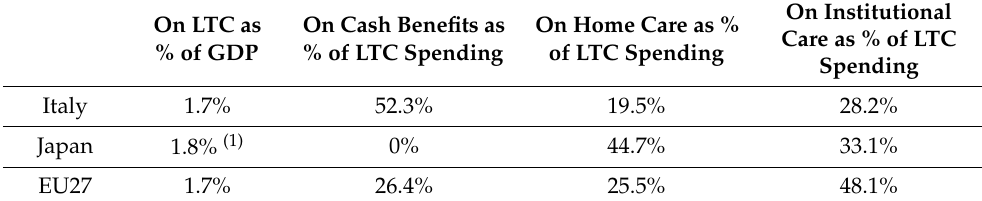
On Institutional